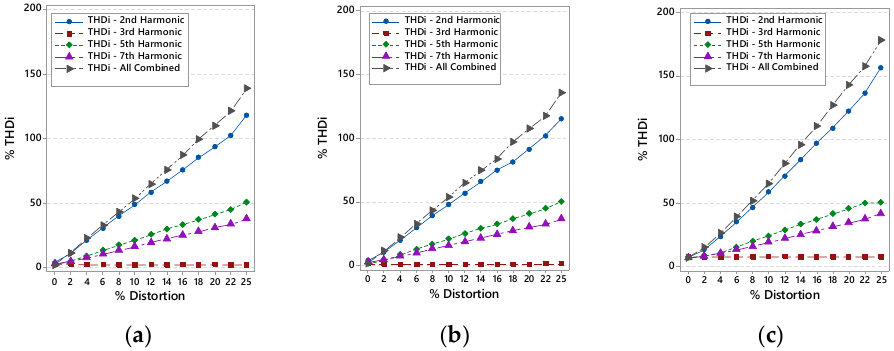
Figure 8. Total current harmonic distortion (THDI) variation for 2nd, 3rd, 5th, 7th and all harmonic order combined for induction motors ( a ) IE2 SCIM; ( b ) IE3 SCIM; ( c ) IE4 LSPMM.